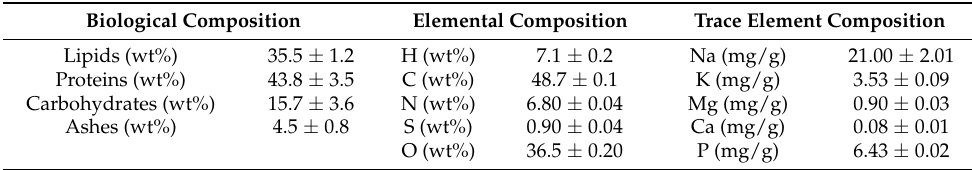
Table 1. Composition of N. gaditana. Biological Composition Elemental